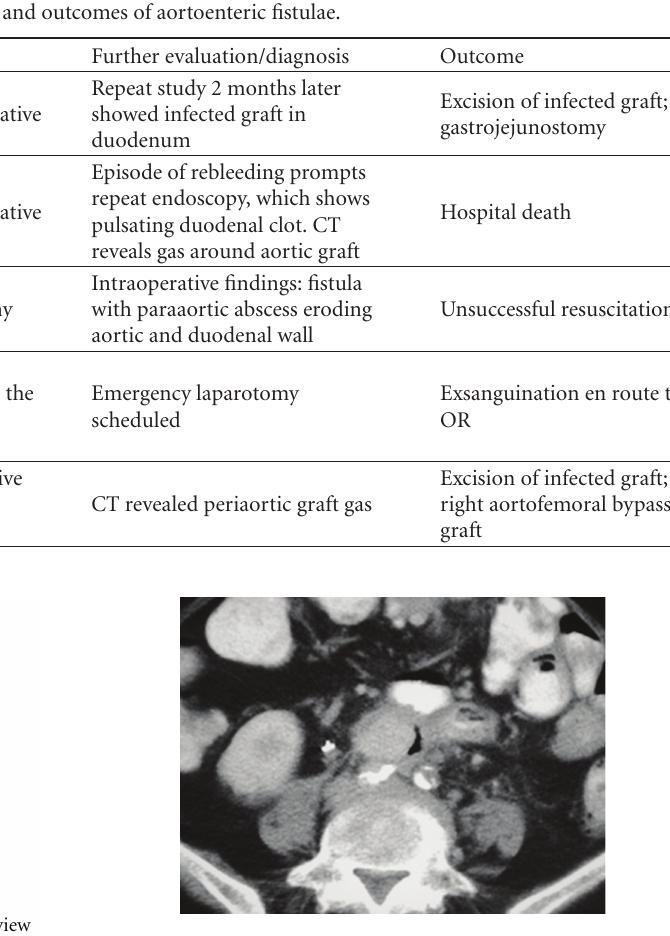
Figure 2: CT image of patient 5, who presented with unexplained fever. CT shows periaortic graft